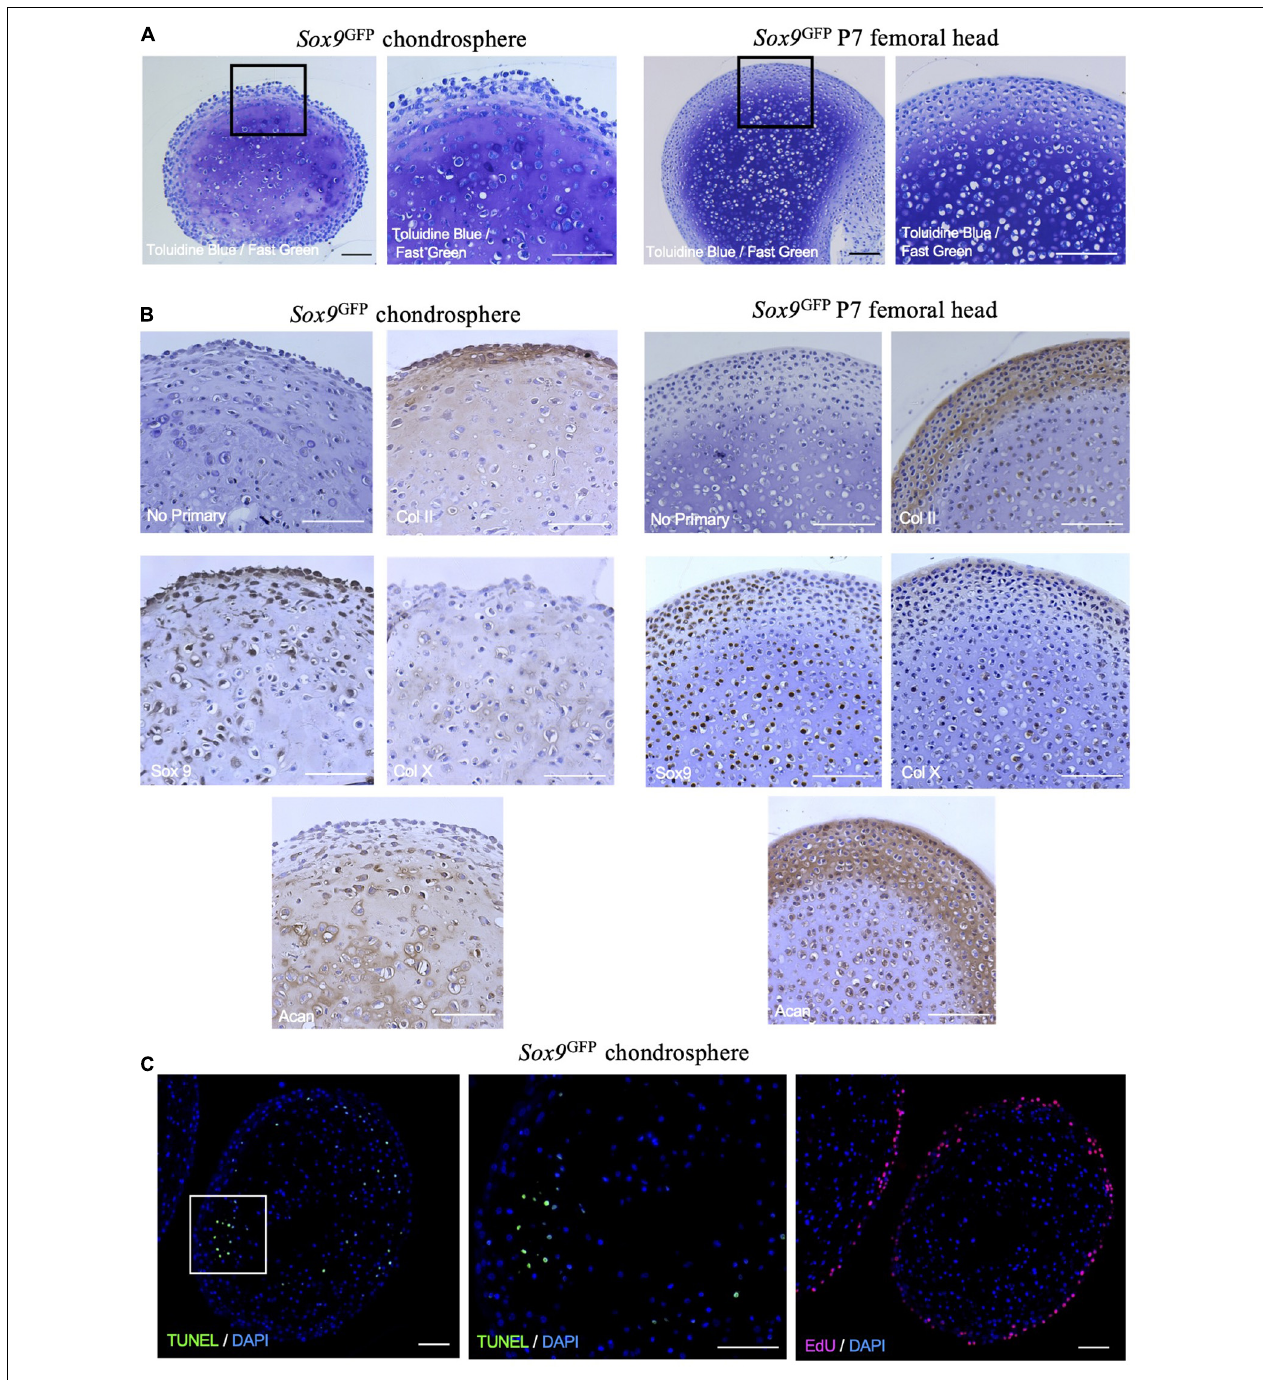
FIGURE 4 | Sox9 GFP chondrospheres self-organize and form extracellular matrix similar to native femoral head after 8 weeks in culture. (A) Toluidine Blue/Fast Green staining for GAGs in Sox9 GFP chondrospheres (left) and P7 femoral head (right). (B) Immunohistochemistry of collagen II, Sox9, collagen X, and aggrecan in Sox9 GFP chondrospheres (left) and P7 femoral head (right). No primary antibody staining is provided as a negative control. (C) TUNEL staining to detect apoptosis (left, middle) and EdU staining to detect proliferation (right) in Sox9 GFP chondrospheres. Scale bar = 100 µ